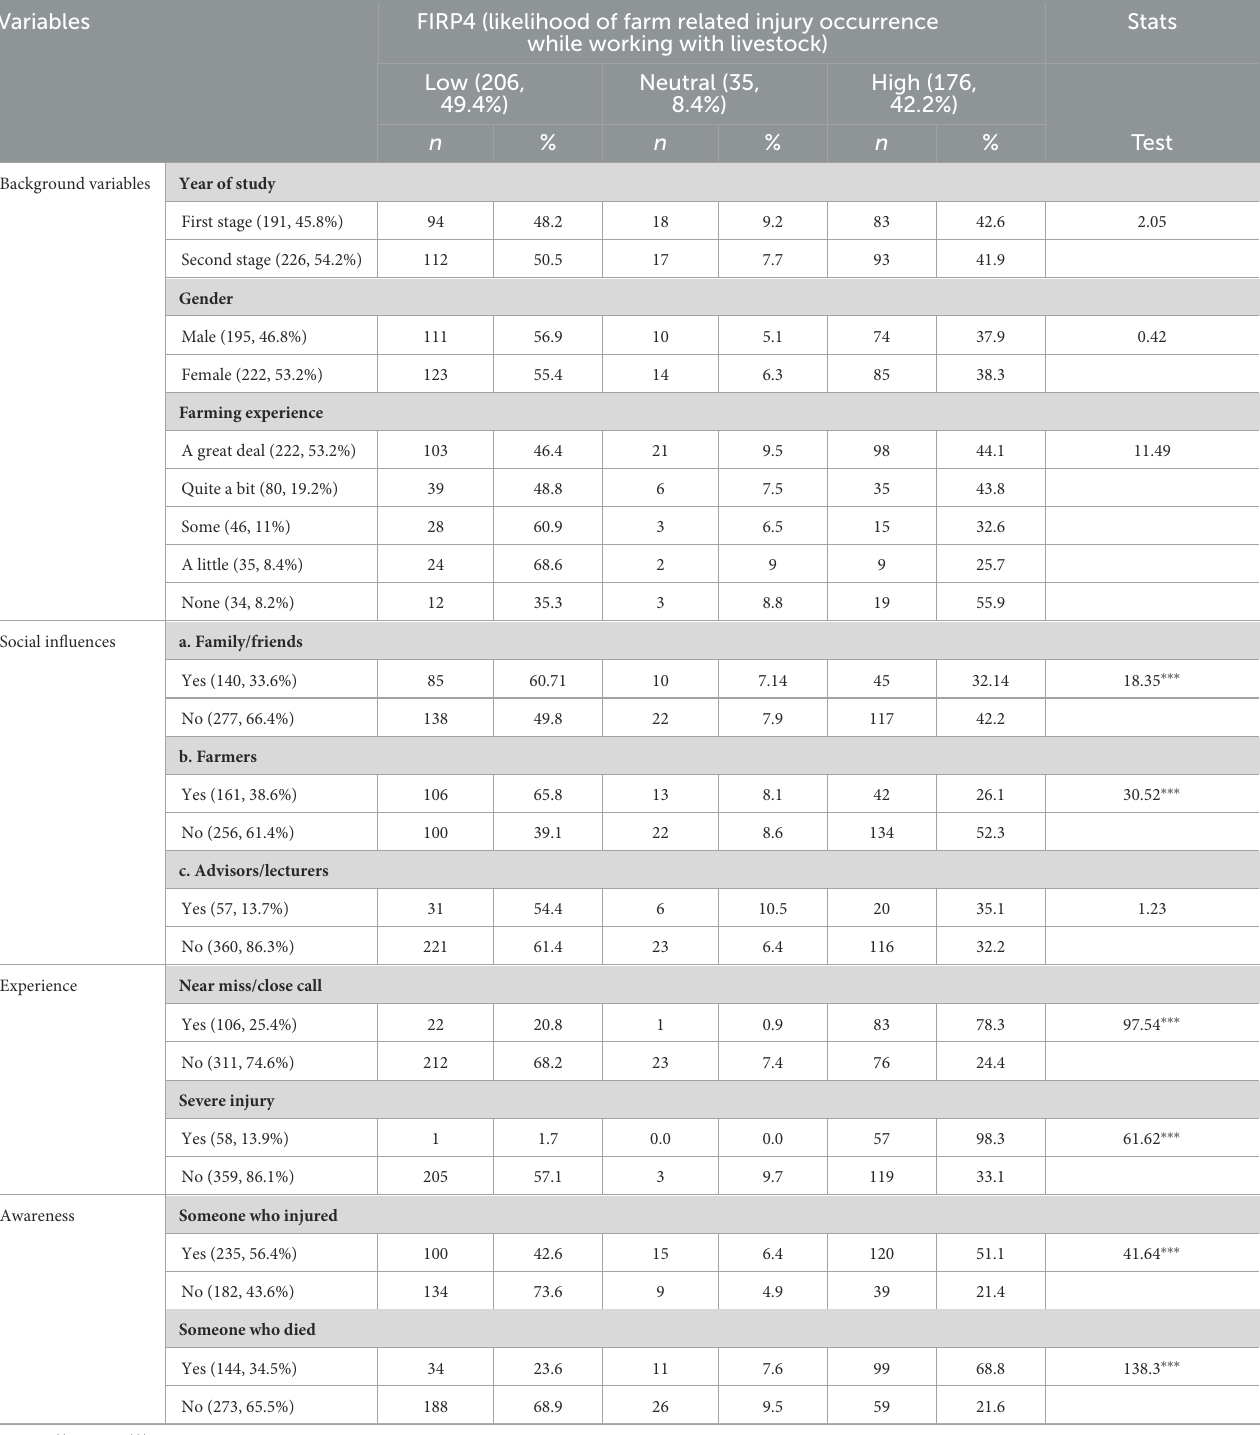
TABLE 4 Chi-square analysis between background and explanatory variables and FIRP4. Variables FIRP4 (likelihood of farm related injury occurrence while working with